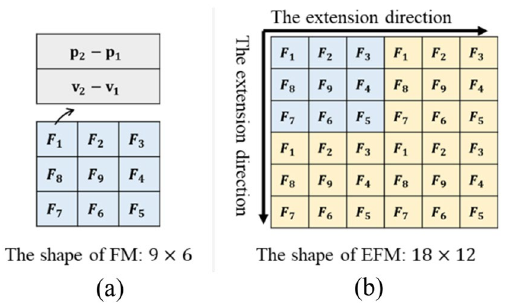
Figure 4. The FM (a) and EFM (b) representation of a